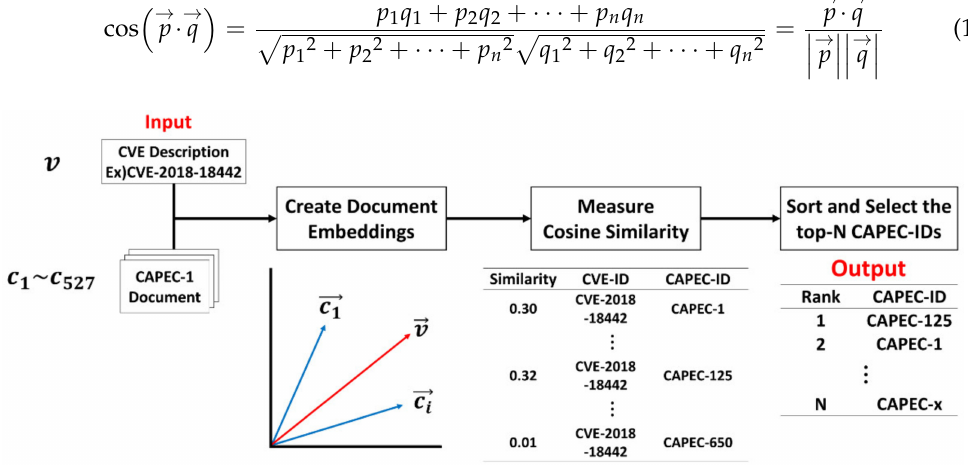
Figure 1. Overview of our